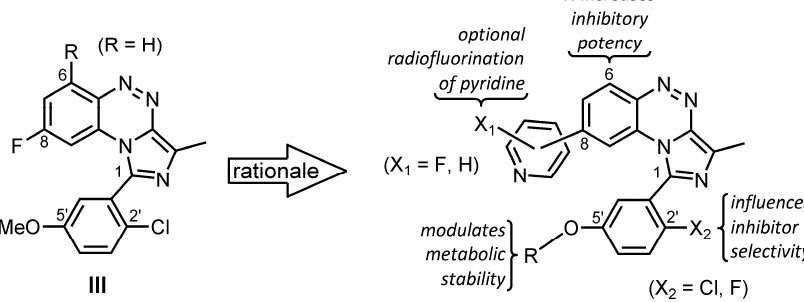
Figure 2 . Approach for structural modification of the lead structure III . Figure 2. Approach for structural modification of the lead structure III